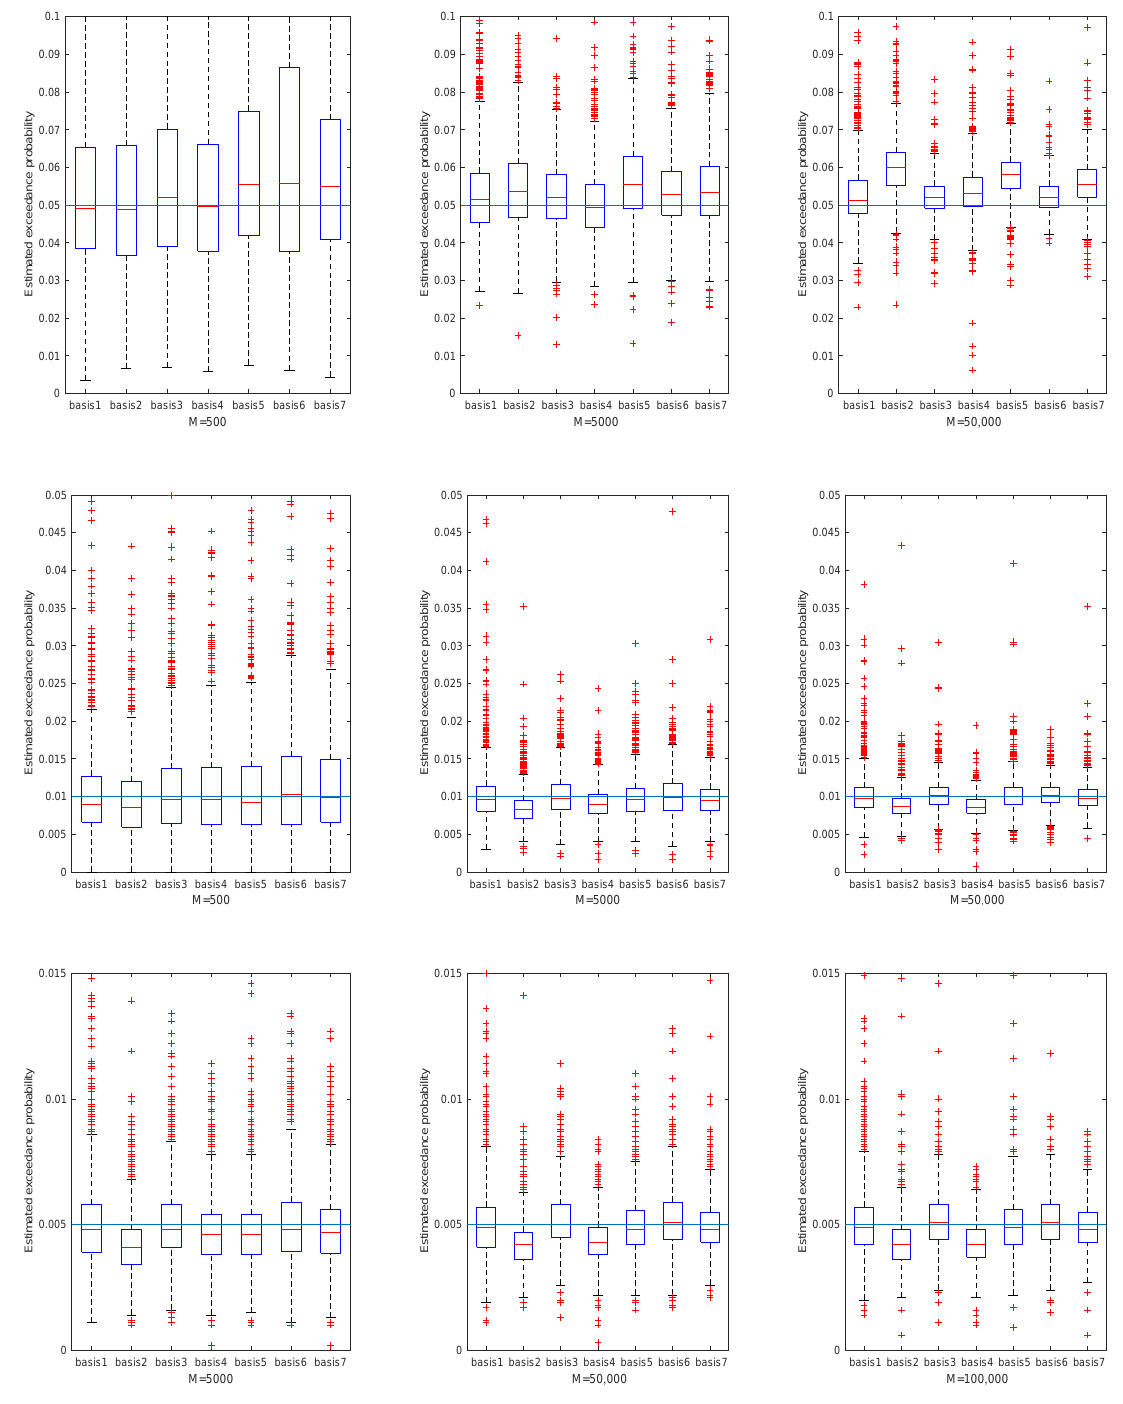
Figure 4. The estimated exceedance probability given the estimated VaR in portfolio 3. Set α = 0.95, 0.99 and 0.995. The three subfigures in the first row correspond to α = 0.95, the three subfigures in the second row correspond to α = 0.99, and the three subfigures in the third row correspond to α =